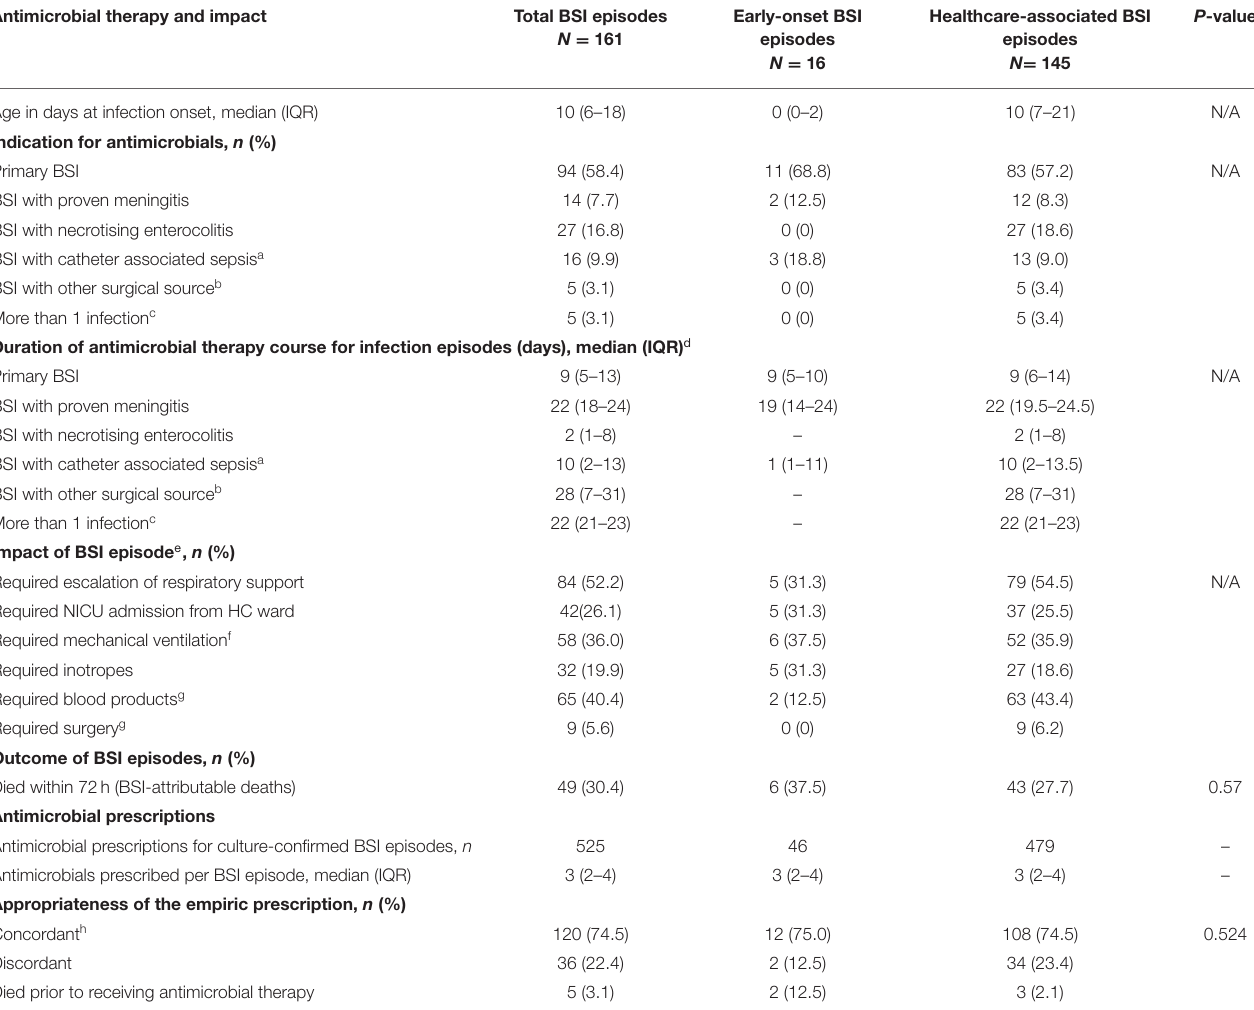
TABLE 2 | Antimicrobial therapy and impact of blood stream infection episodes (161 episodes in 141 neonates)—a comparison between early onset and healthcare associated BSI. Antimicrobial therapy and